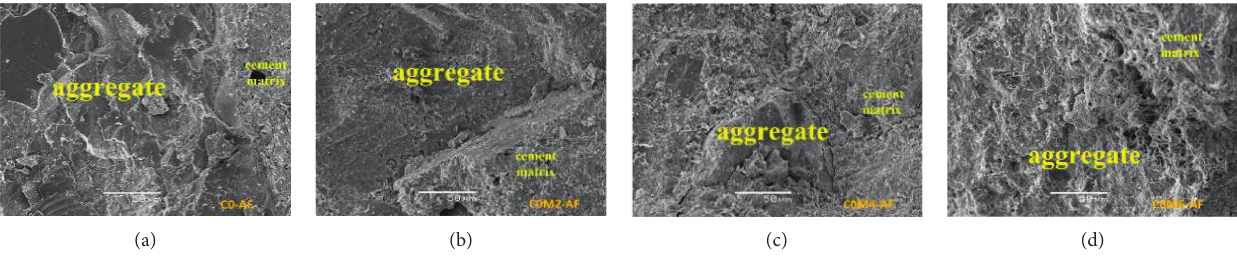
Figure 5: Characteristics of microstructure of CGCC after freeze-thaw cycles (500x).